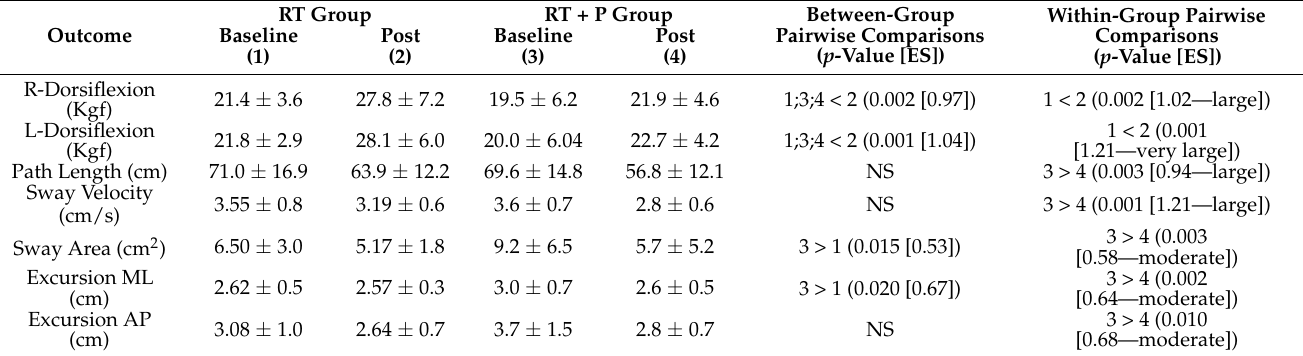
Table 4. Between-group and within-group pairwise